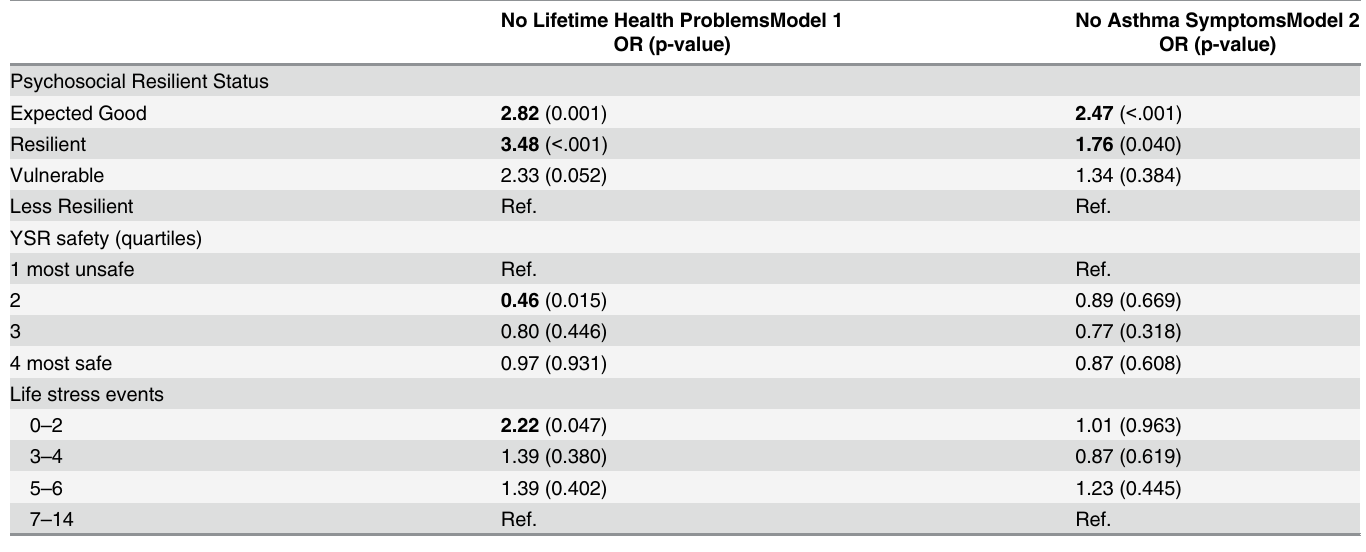
Table 3. Modeling 1 the relative effect of Psychosocial Resilient Status on Physical Health Status of 12 – 17 year old Aboriginal Youth (N = 5180, 95% CI 5130,